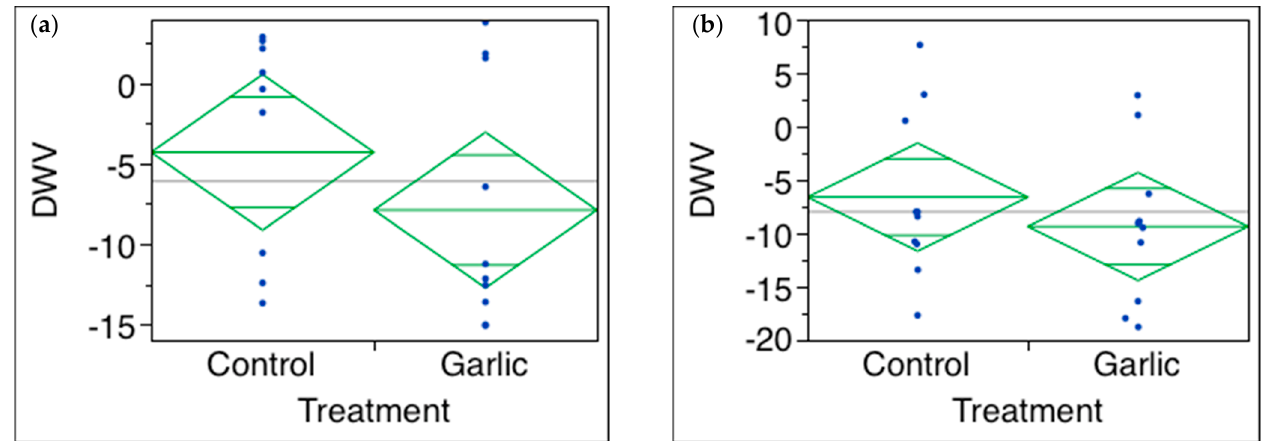
Figure 4. One-way analysis of DWV by treatment. Cup study with newly emerged bees, 10 replicate cups/treatment or control. The control is DWV-inoculated sugar-fed control. GAR was DWV-inoculated with garlic oil supplemented with sugar water at 1000 ppm ( a ) and 10,000 ppm ( b ). The Y-axis shows Δ Cq. The diamond tips represent the 95% confidence intervals for the ANOVA, with the mean designated with the middle horizontal line across each diamond. Increased values indicate an increased DWV load. ( a ) Mean DWV-fed control = − 4.2800 +- 2.3144 (SE) (mean DWV- and garlic-fed = − 7.8870 +- 2.3114 (SE), p = 0.2844, n = 10). ( b ) Mean DWV-fed control = − 6.6170 +- 2.4050 (SE); (mean DWV- and garlic-fed = − 9.3700 +- 2.4050 (SE), p = 0.4288, n = 10).